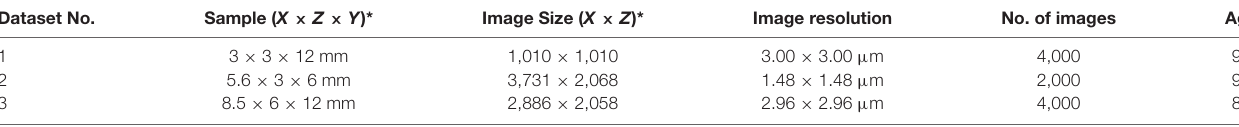
TABLE 1 | Age and dimension of related high-resolution episcopic imaging (HREM) datasets. Dataset No.